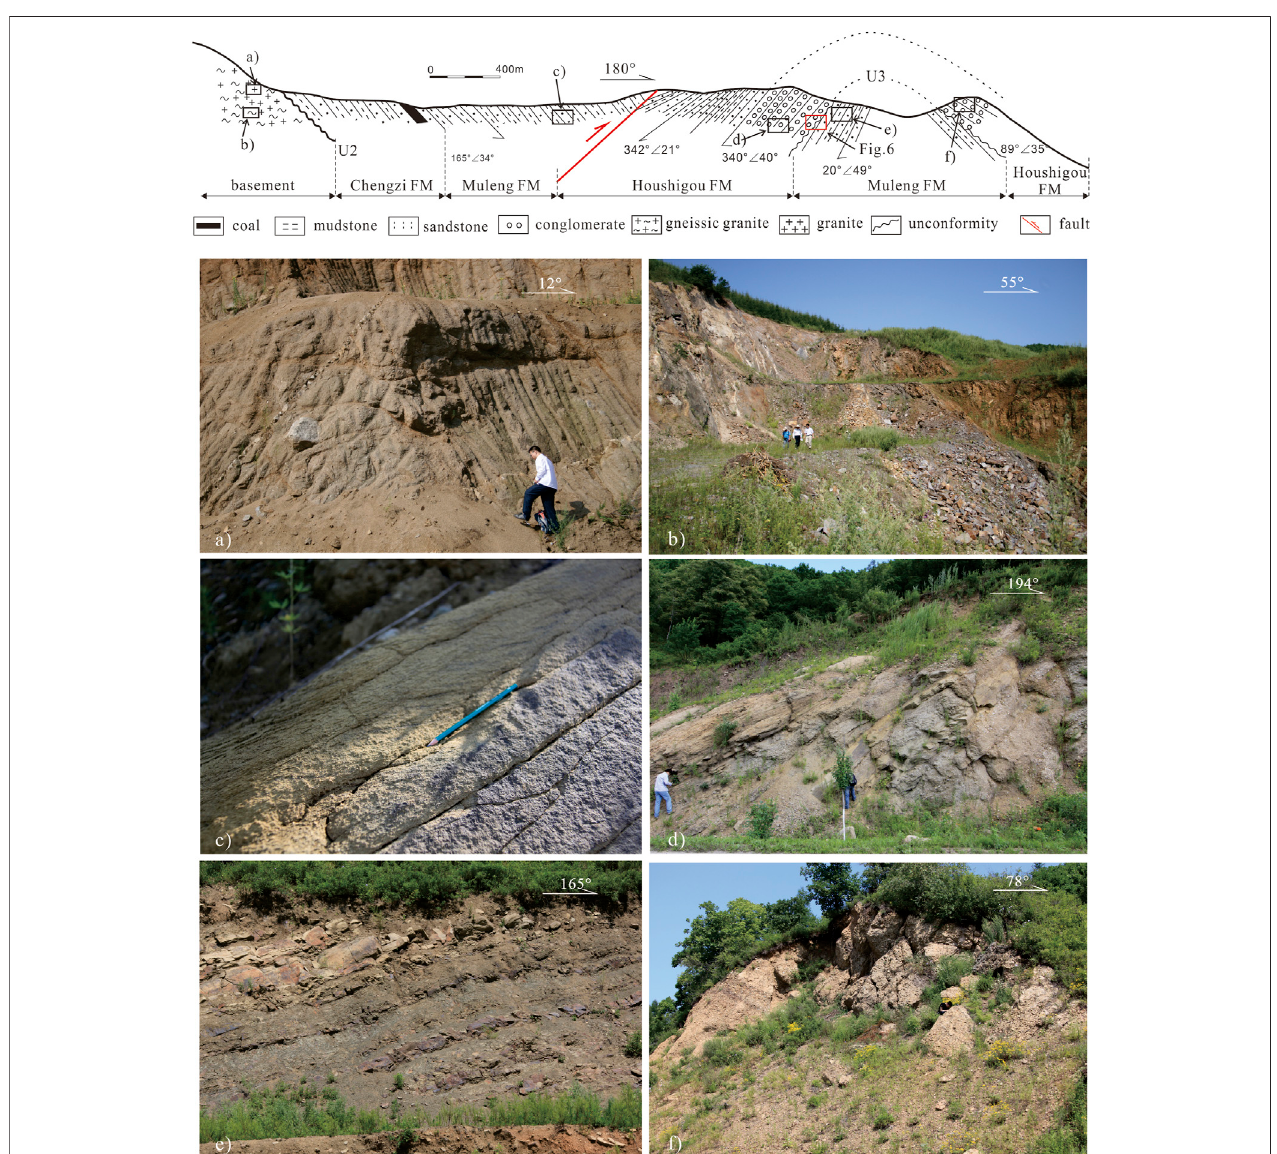
FIGURE 4 | Outcrop on the side of the road from Guangxin Town to Hongxin Town, showing two unconformities between the Lower Cretaceous Chengzihe Fm and the Pre-Mesozoic basement, and between the Houshigou and Muleng Fms. An anticline on the upper outcrop is also shown. (A) Proterozoic migmatitic granite, which has been cut by multiple granite dikes. (B) Strongly deformed Proterozoic metamorphic rock containing dark grey schist, gneiss, and marble. (C) Grey and grey-white coarse sandstone of the Muleng Fm, oblique bedding is developed. (D) Interbedded conglomerate and sandstone of the Houshigou Fm. (E) The Muleng Fm, the upper part is grey and grey-white coarse sandstone, the lower part is grey-black siltstone and silty mudstone. (F) The thick beds of conglomerate of the Houshigou Fm.